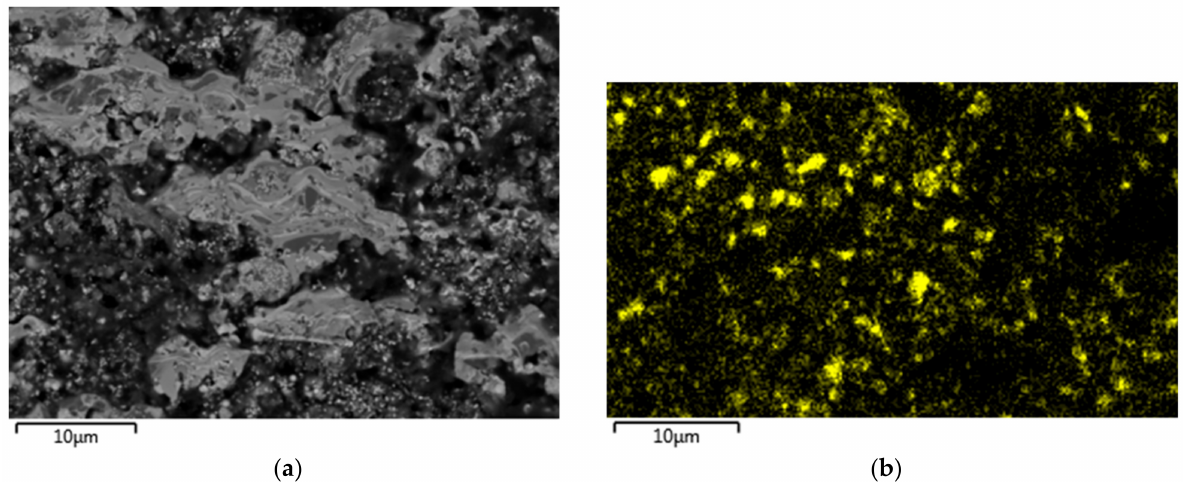
Figure 4. Micrograph of Al 2 O 3 /TZ-3YS/SiC with fructose coating at 2500 × : ( a ) micrograph at backscattering mode; ( b ) mapping performed by EDX where Si is marked.